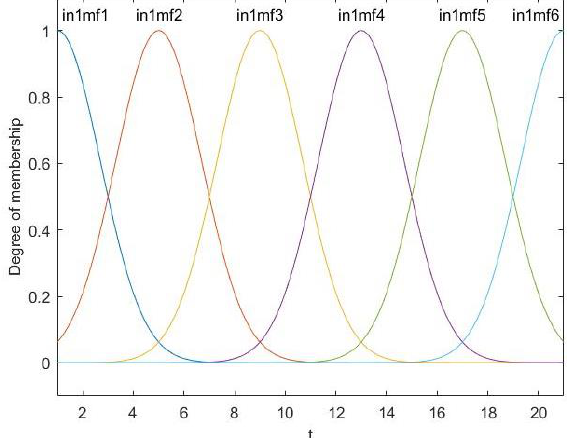
Figure 1. Membership function for input variable 